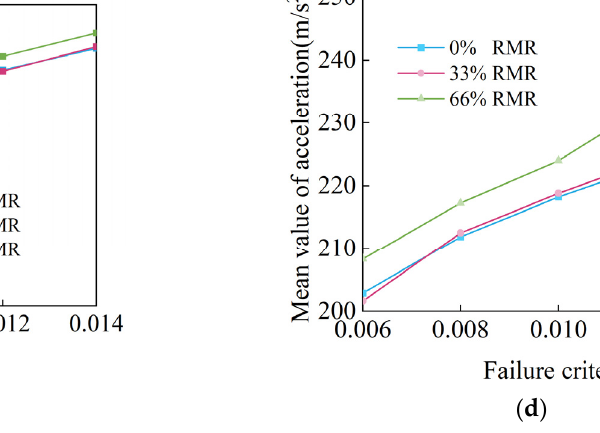
Figure 12. ( a ) Failure criteria versus effective value of velocity under different RMR. ( b ) Failure criteria versus effective value of acceleration under different RMR. ( c ) Failure criteria versus mean value of velocity under different RMR. ( d ) Failure criteria versus mean value of acceleration under different RMR.